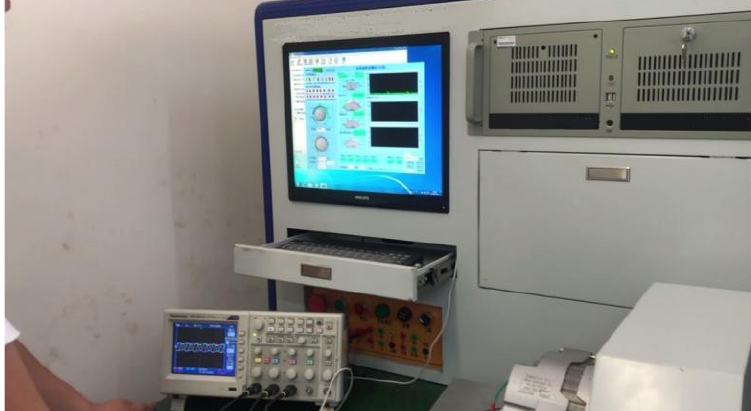
Figure 12. The experimental scene.